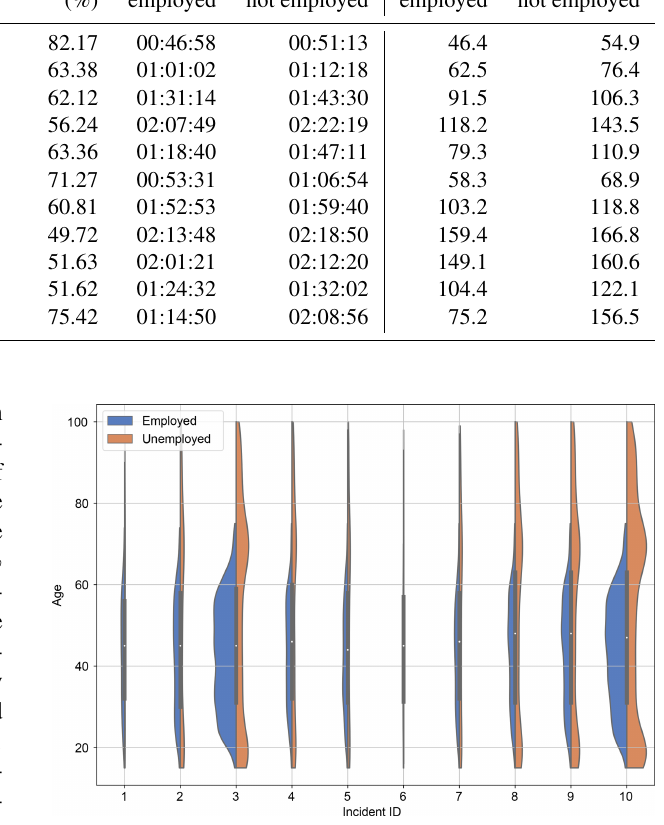
Figure 4. Kernel density estimates of the number of agents by age and employment status of agents affected by each